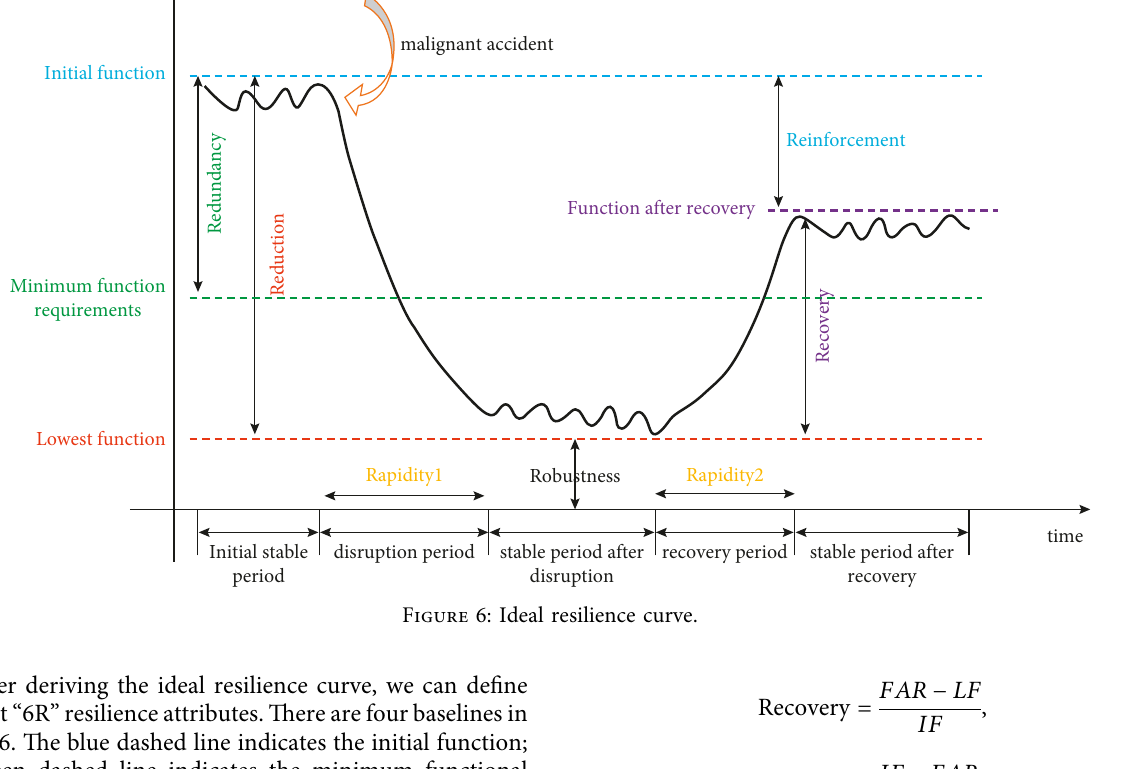
relevant “6R” resilience attributes. There are four baselines in Figure 6. The blue dashed line indicates the initial function; the green dashed line indicates the minimum functional requirements; the red dashed line indicates the lowest function, and the purple dashed line indicates the function after recovery. Redundancy refers to the difference between